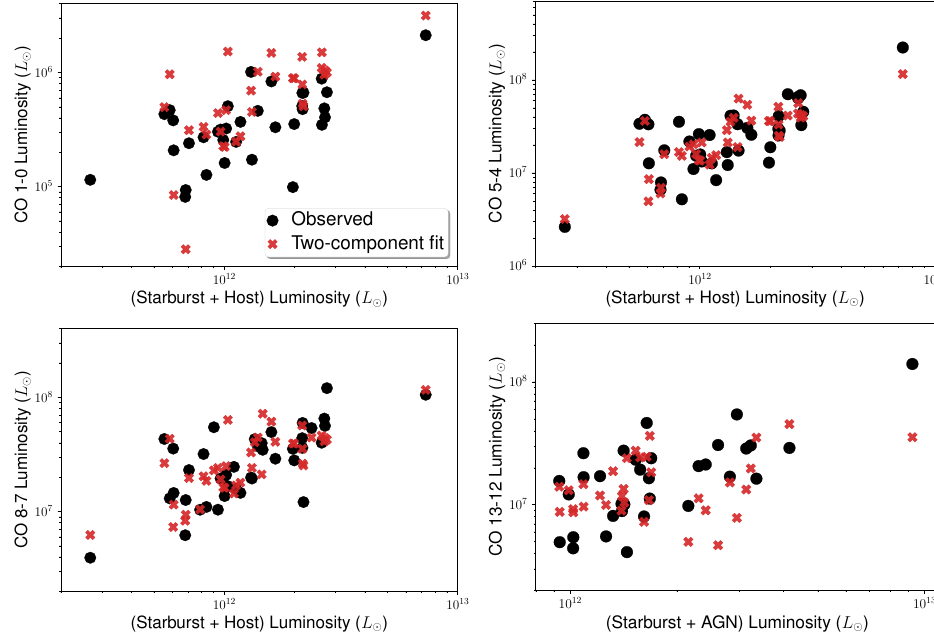
Figure 5. Example comparisons between CO luminosity and the sum of two component luminosities (starburst and host for 1–0, 5–4, and 8–7, starburst and AGN for 13–12). The red crosses show the results for a linear fit between the two component luminosities and the CO luminosity, of the form L CO = α L A + β L B + γ (Section